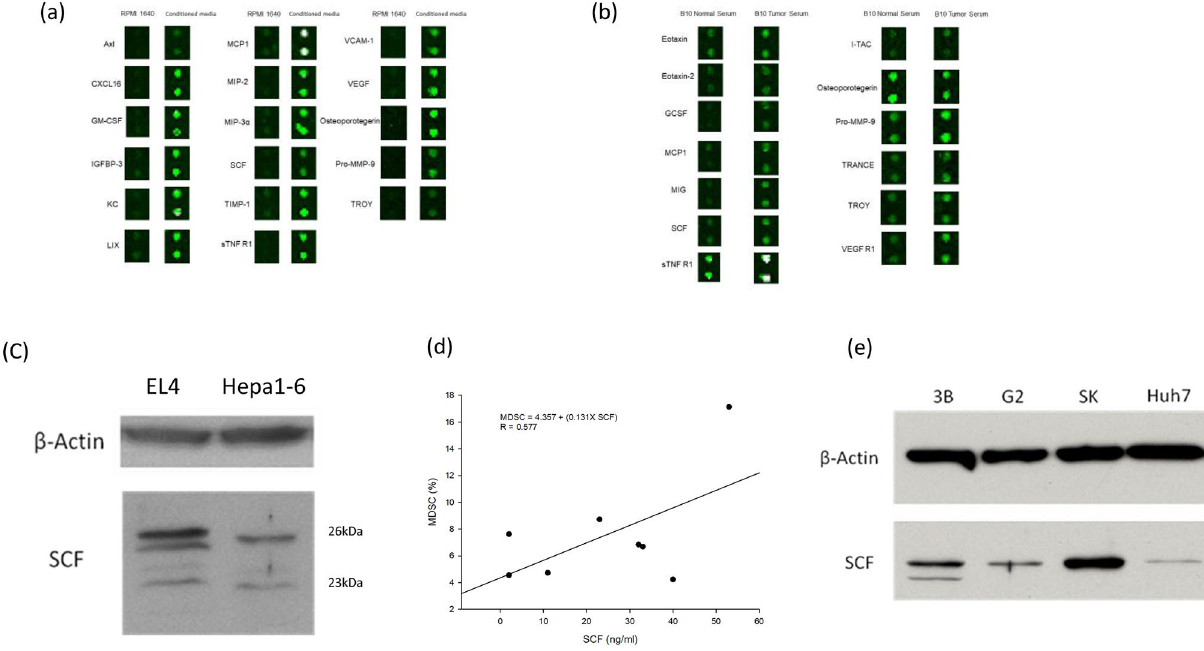
Figure 3. Eligible cytokines contributing to expansion of MDSCs. ( a ) Overproduced cytokines were identified by cytokine antibody array in the conditioned medium. They included GM-CSF, SCF, MCP-1, sTNF-R1, and pro-MMP-9. ( b ) Cytokines in the serum from naïve and Hepa1-6 tumor-bearing mice were identified by cytokines array. SCF, MCP-1, G-CSF, sTNF-R1, and pro-MMP-9 were increased in the serum of tumor-bearing mice. ( c ) Western blotting showed soluble and membrane-bound forms of SCF produced by Hepa1-6 cells and EL4 cells ( d ). When SCF was measured by ELISA, the serum level of SCF tended to correlate with MDSC frequency in tumor-bearing mice: MDSC (%) = 4.357 + 0.131 × SCF (ng/ml) (r = 0.577). ( e ) Western blotting also showed that human HepG2, 3B, SK, and Huh7 cells produced